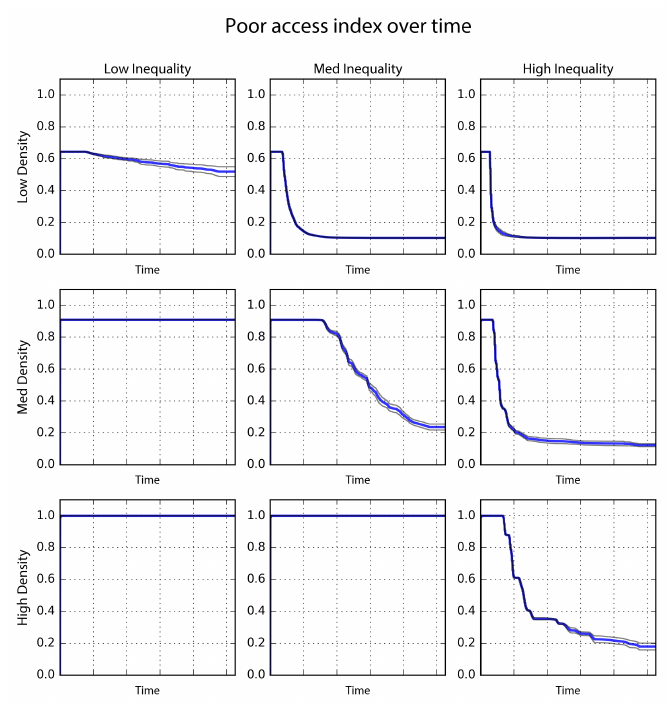
Figure 11. Time series of the poor access indicator values produced by the model when parameterized with varying combinations of low, medium, and high density and inequality values. The mean value across 50 runs is blue and the gray lines depict the 95% confidence interval.